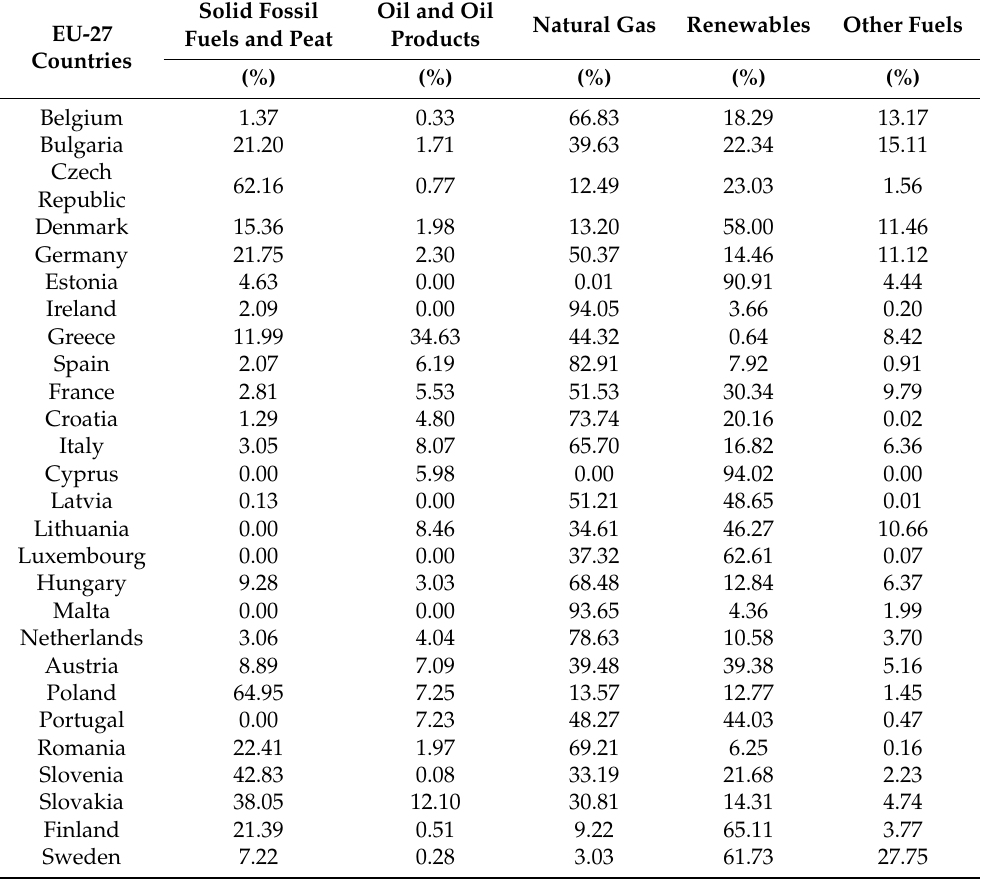
Table 1. The energy mix of the EU Member States, source: own study based on [8].